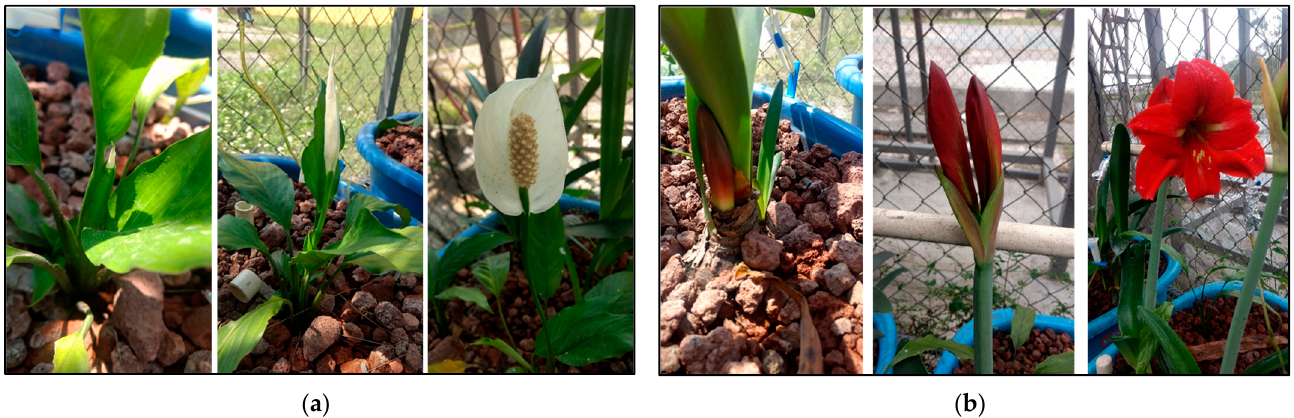
Figure 9. Ornamental plant flowering in the CW cells: ( a ) Spathiphyllum ; ( b ) Hippeastrum .